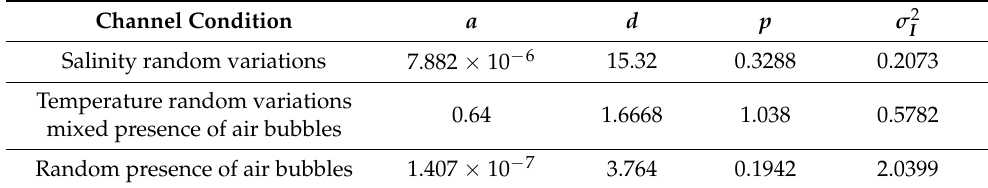
Figure 4. BERs of the (5, 2) MPPM UWOC system with/without LDPC code in the GG-distributed fading channel with different scintillation indexes. Table 2. The parameters of GG-distributed fading channels, adopted from